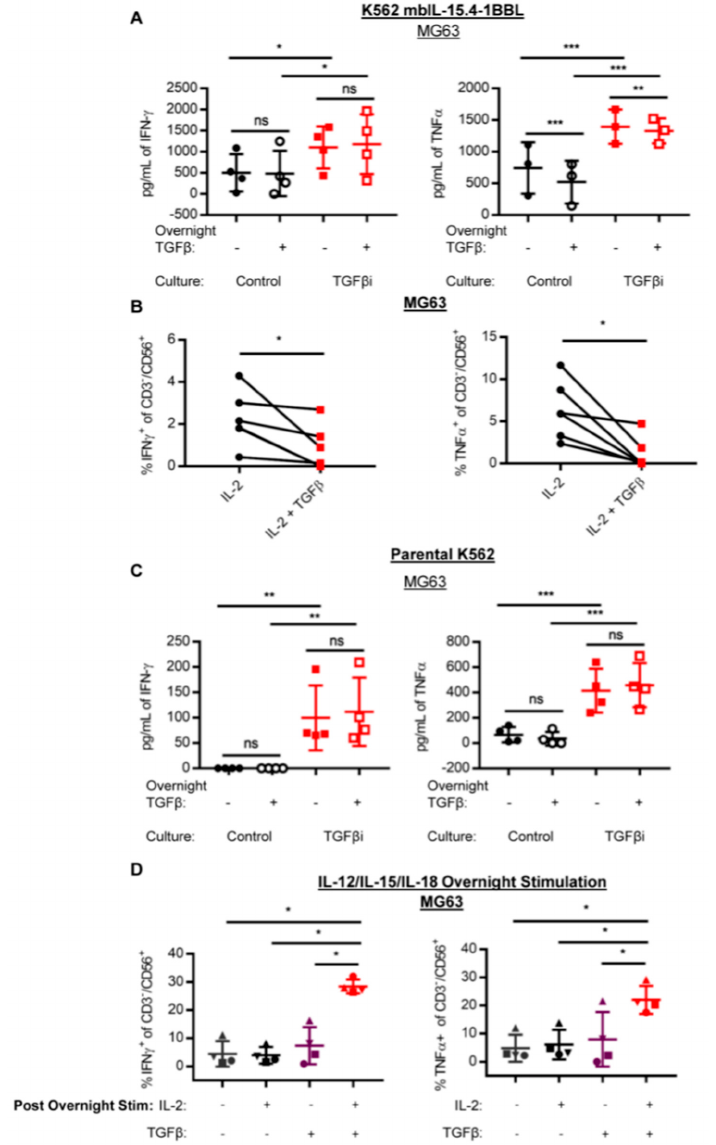
Figure 2. NK cell activation is required for TGF β induced cytokine hypersecretion . NK cells were